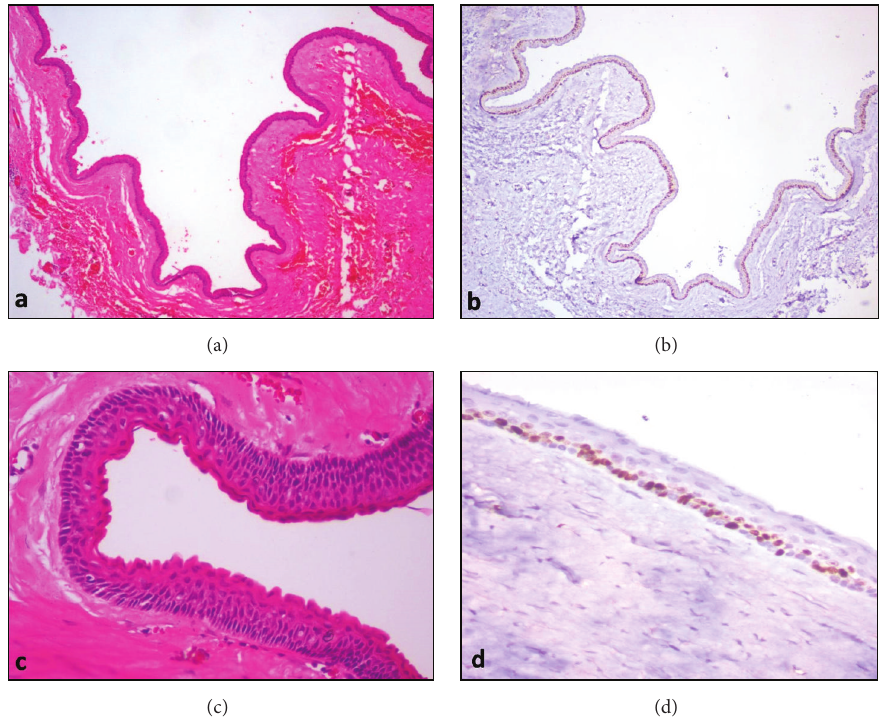
Figure 5: (a) Hematoxylin and eosin stained histopathological section of the lesion showing cystic epithelium of odontogenic keratocyst with numerous infoldings ( × 40). (b) Corresponding IHC image showing nuclear expression of Ki-67 seen continuously in the basal layer ( × 40). (c) High power view showing 5–7 cell layer thick, corrugated parakeratinized cystic epithelium with columnar basal cells exhibiting palisading nuclear polarity (H&E stain, × 200). (d) Corresponding IHC image showing nuclear expression of Ki-67 continuously in the basal layer and sparsely in the parabasal layer. Superficial layers are completely free of Ki-67 expression ( × 200).